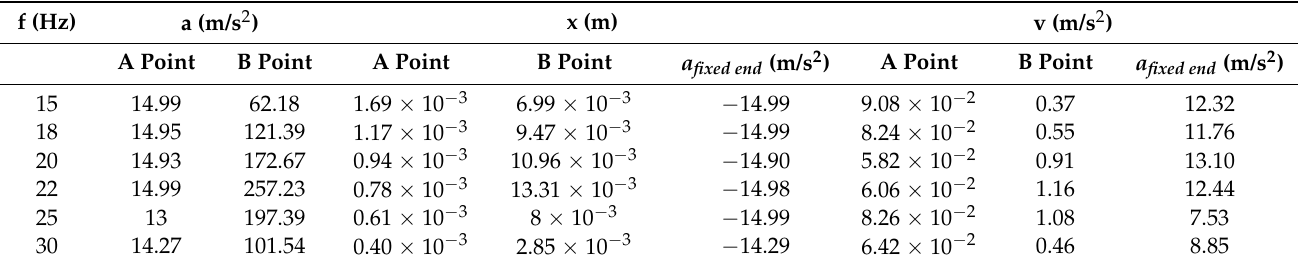
Table 4. Characteristic values, determined experimentally, for the frequency range from 15 Hz to 30 Hz at an excitation acceleration of 15 m/s 2 at the fixed (A point) and free points (B) for the BRM evaluation.